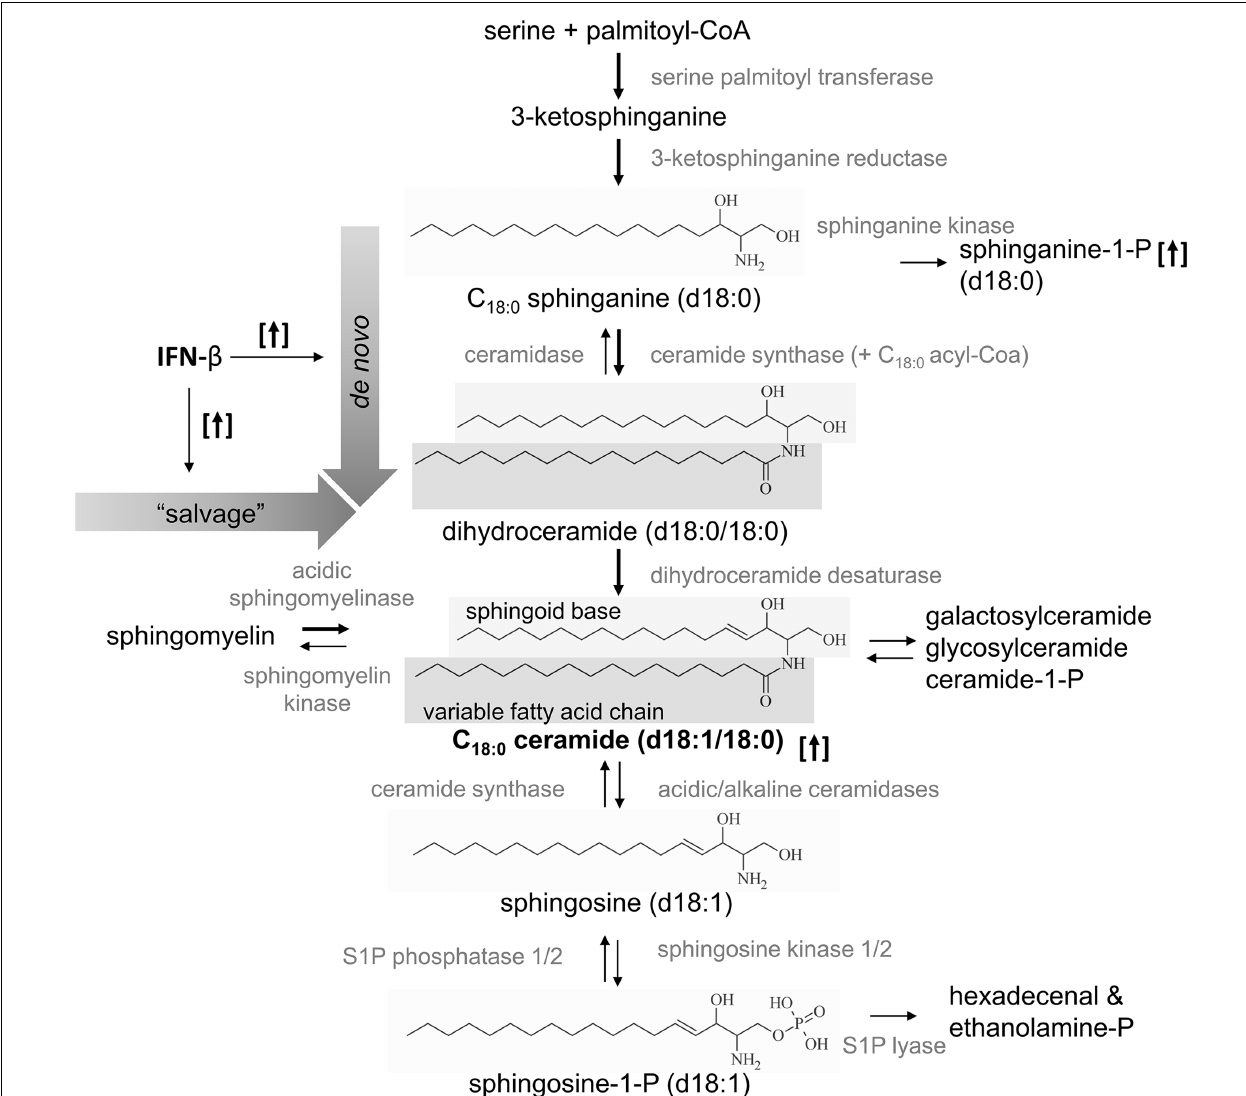
FIGURE 3 | Schematic overview of the generation of C 18 : 0 ceramide and the supposed effect of IFN- β . Ceramides are produced de novo by serine and palmitoyl-CoA or by “salvage” pathways, with recycling of sphingomyelin or sphingosine-1-phosphate. IFN- β increased e.g., C 18 : 0 ceramide and sphinganine-1-phosphate (with a C 18 -backbone) as indicated by the arrows in brackets. Accordingly, the de novo synthesis and/or the “salvage” pathway may be activated by IFN- β therapy as indicated by bold